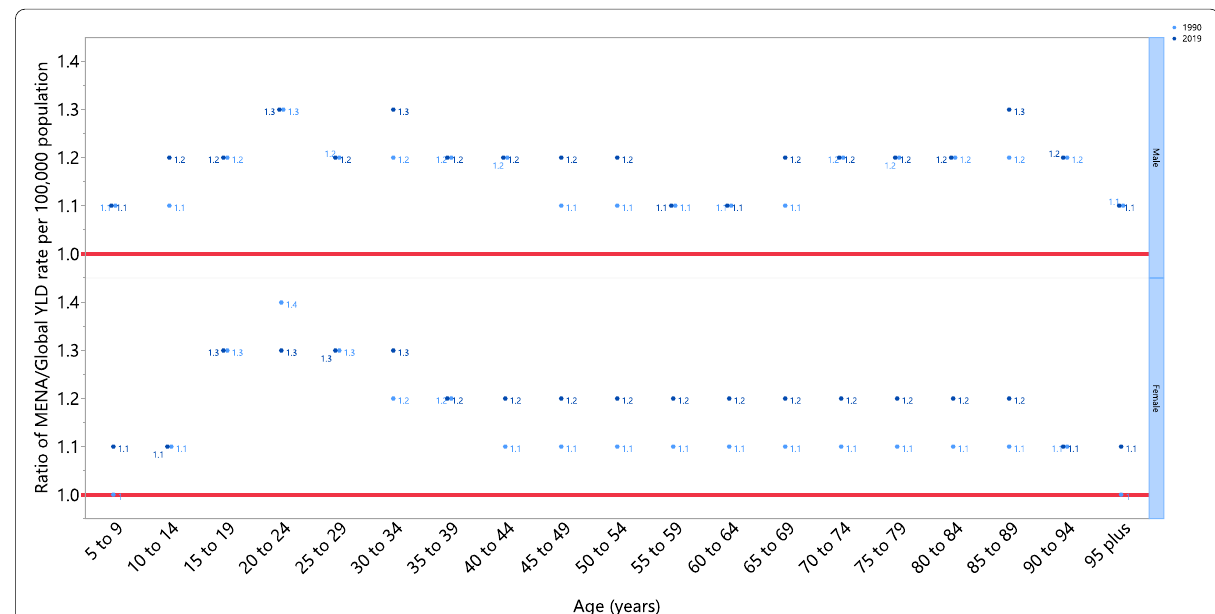
Fig 3 Ratio of the Middle East and North Africa region to the global tension‑type headache YLD rate according to age group and sex, 1990–2019. YLD years lived with disability. (Generated from data available from http:// ghdx. healt hdata. org/ gbd‑ resul ts‑ tool). =